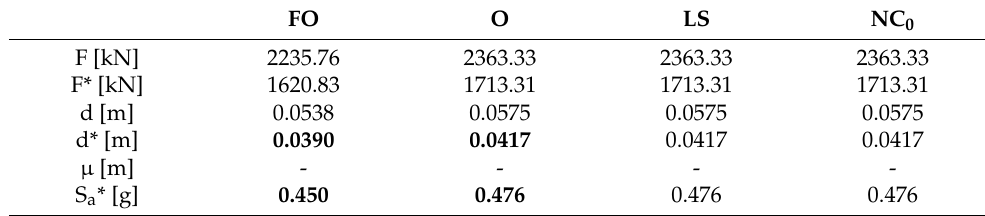
Table 11. Nassar and Krawinkler approach